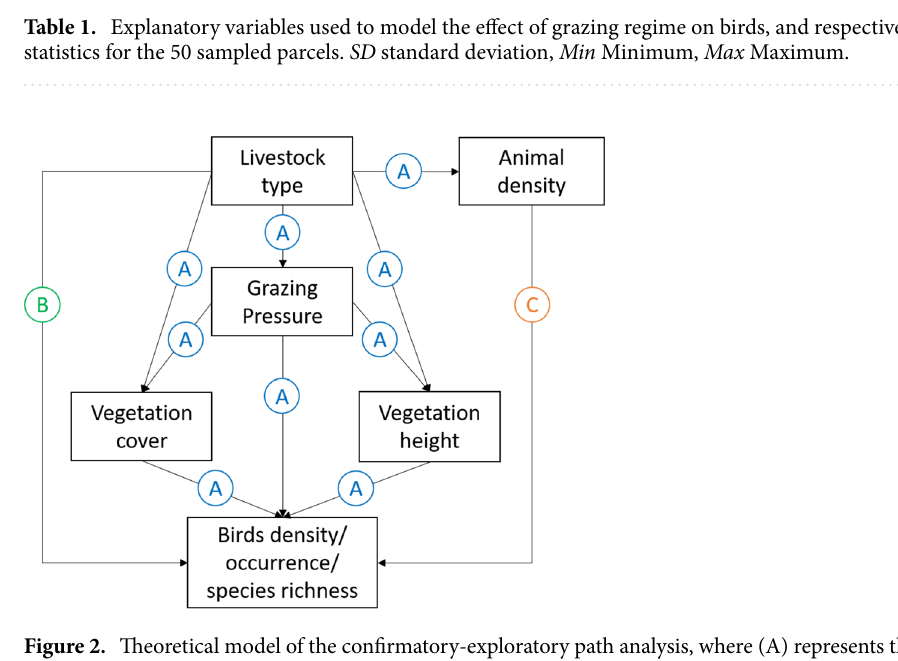
Figure 2. Theoretical model of the confirmatory-exploratory path analysis, where (A) represents the paths of the indirect effect of livestock type via impacts on vegetation structure; (B) represents the livestock type specific direct effects; (C) represents the direct effect of animal density through disturbance impacts on birds. For detailed information of model construction, see Supplementary Information